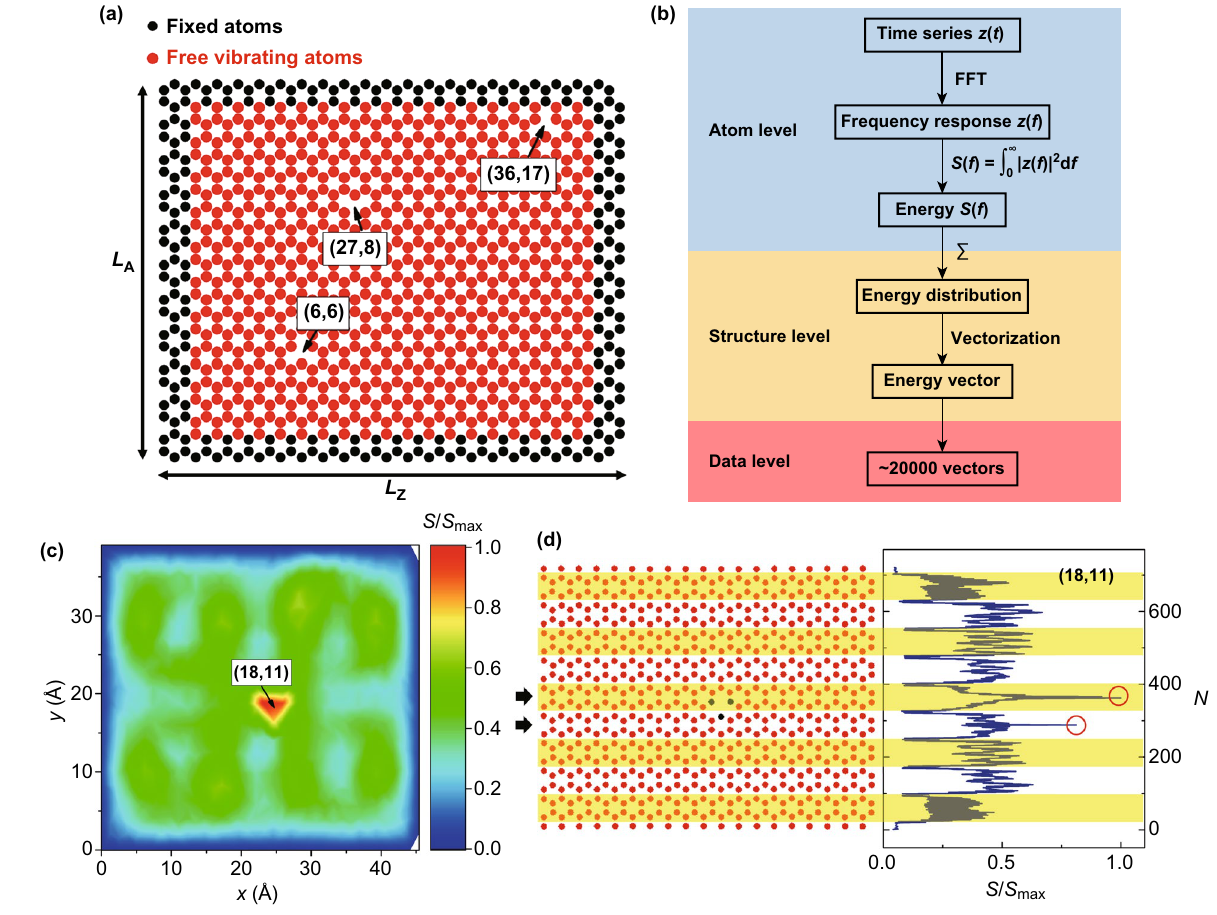
Fig. 1 Descriptions of graphene sheets with vacancies and the procedure of data preparation. a Schematic of the defected graphene sheet and vacancy indexing, where a graphene sheet containing vacancies (6,6), (27,8), and (36,17) is used as an example. b Route of data preparation. c 2D energy distribution of graphene sheet with a vacancy (18,11), fixed atoms on the edges are not included in the contour plot. d 1D energy vec- tor compressed from the 2D energy distribution and its correlation with the original graphene lattice